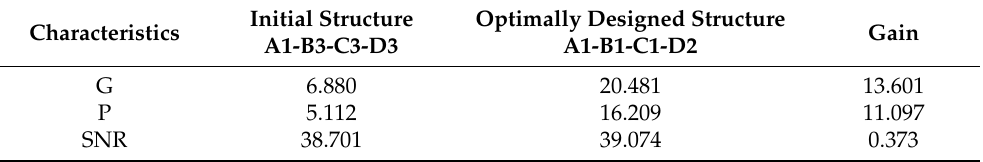
Table 9. Comparison between the initial structure and the optimally designed